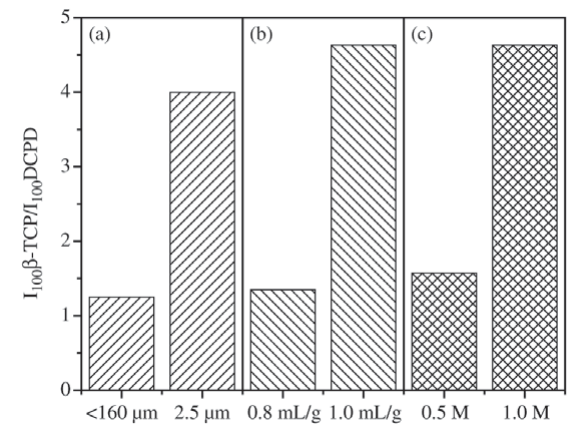
Figure 2. X-ray powder diffraction pattern of the resulting cement after mixing β -TCP (fine) and L (P/L = 1.0 ml/g), setting and age- ing. (cid:134) : CaHPO .2H O (JCPDF 4 2